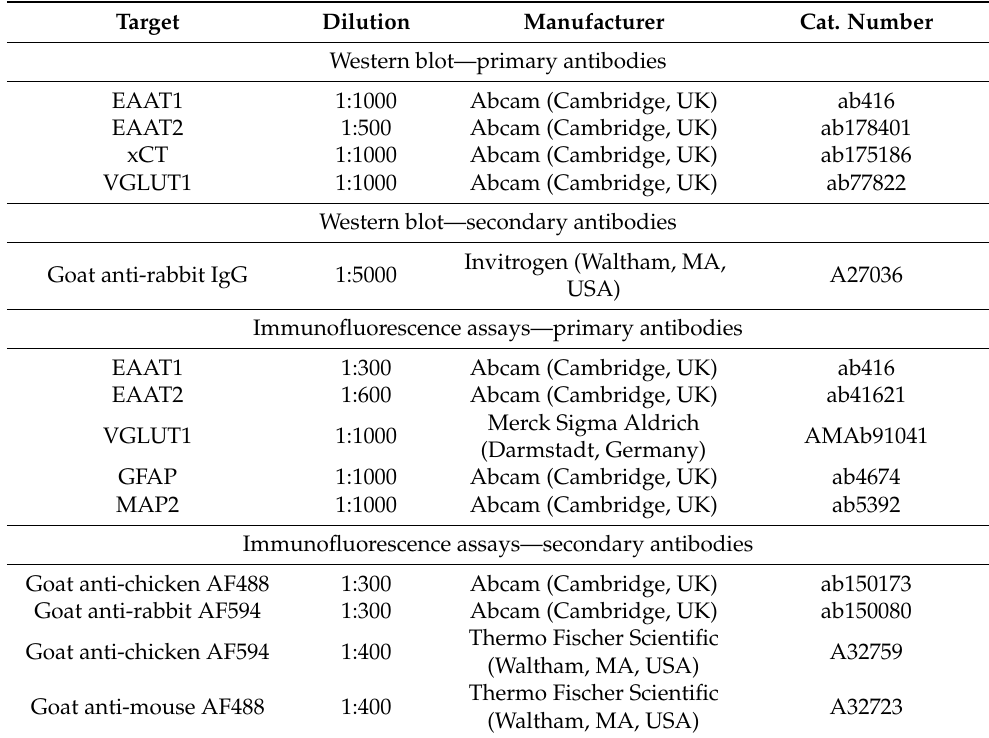
Table 1. List of antibodies used and their